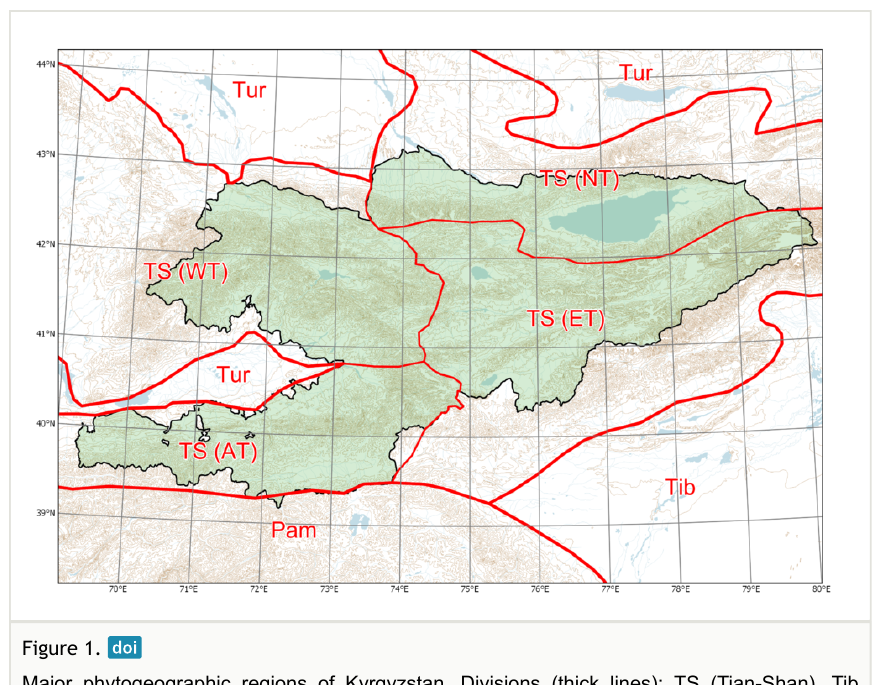
inferred from the past (50-100 years ago) and current (the latest 20 years) distributional data, and expressed as decreasing, stable or increasing without quantification.